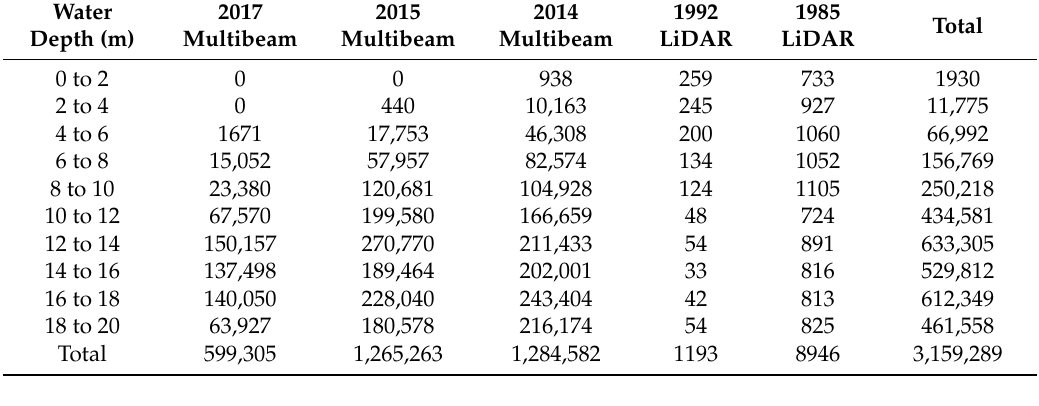
Table 2. Distribution of hydrographic survey points for water depth ranges up to 20 m.